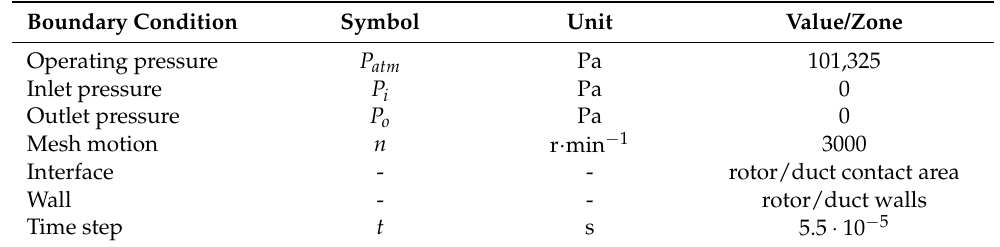
Table 2. Boundary